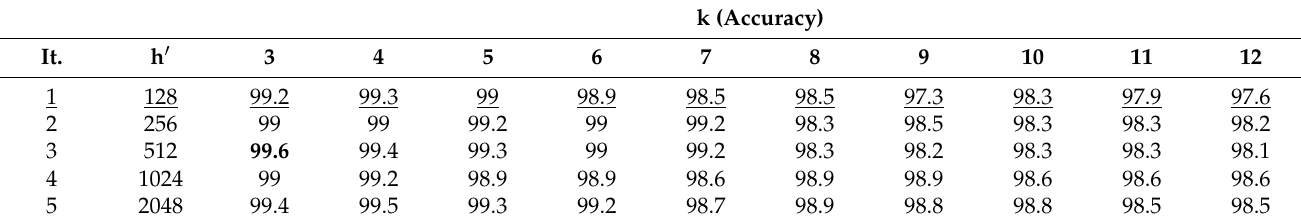
Table 2. Subsequent steps of algorithm applied in search of an optimum parameter for method to select kNN. k (Accuracy)